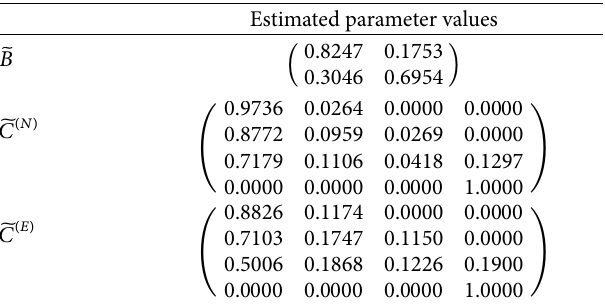
Table 4: Posterior inference for parameters of DCMM Estimated parameter values